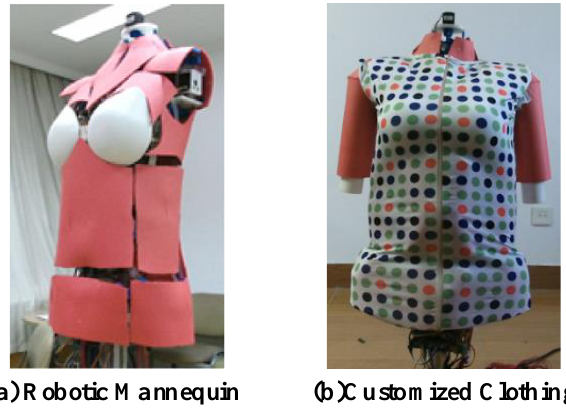
Figure 10. A real reference experimental platform. ( a ) we use a robotic mannequin developed in our lab [36]; ( b ) the clothing on the robotic mannequin will be reconstructed to test the adaptive weight field.